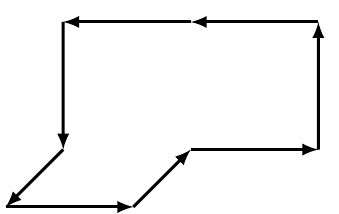
Figure 1 . Example for the three-dimensional path C used in the simulation for the pseudoscalar glueball 0 − + . This shape is rotated by the 24 elements of the cubic